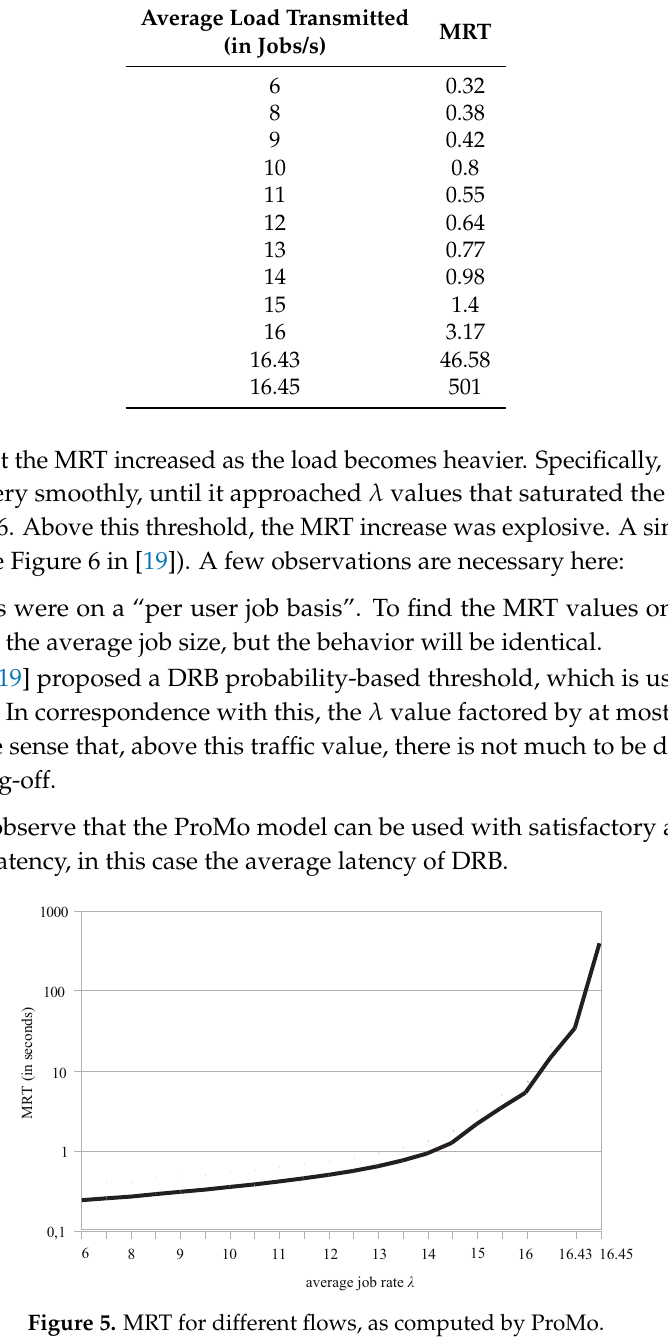
Figure 5. MRT for different flows, as computed by